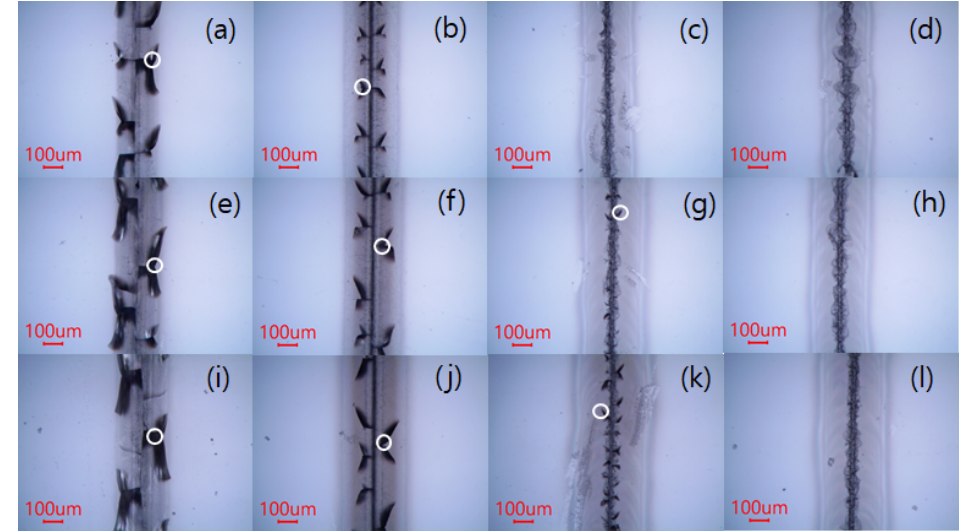
Figure 4. Optical images of the glass surface damaged by a single laser scan. Laser power: ( a – d ) 2.28 W, ( e – h ) 2.8 W, and ( i – l ) 3.32 W. Scan speed: ( a , e , i ) 5 mm/s; ( b ), ( f , j ) 15 mm/s; ( c , g , k ) 25 mm/s; and ( d , h ), and ( l ) 35 mm/s. The circle in the figure denotes a crack.